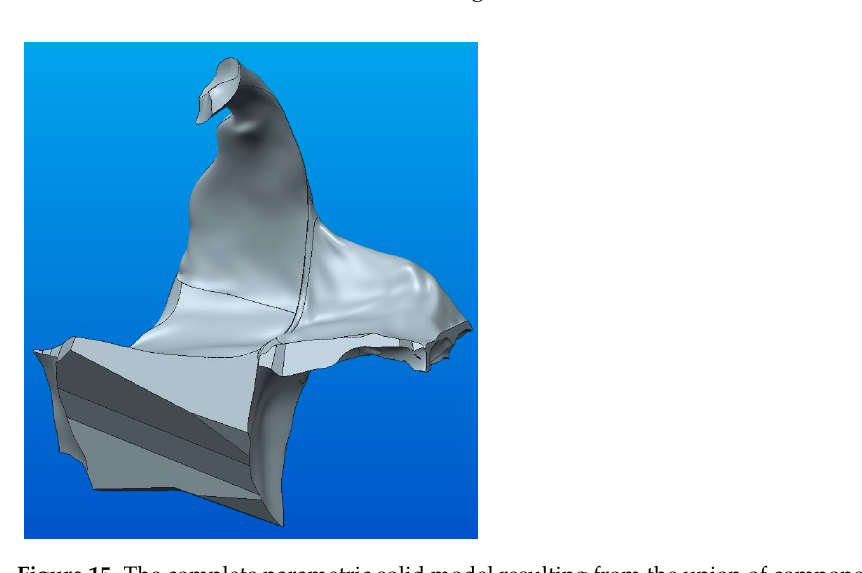
Figure 16. Comparison between generated and initial STL models (in yellow): ( a ) CATIA model; ( b ) Creo model.